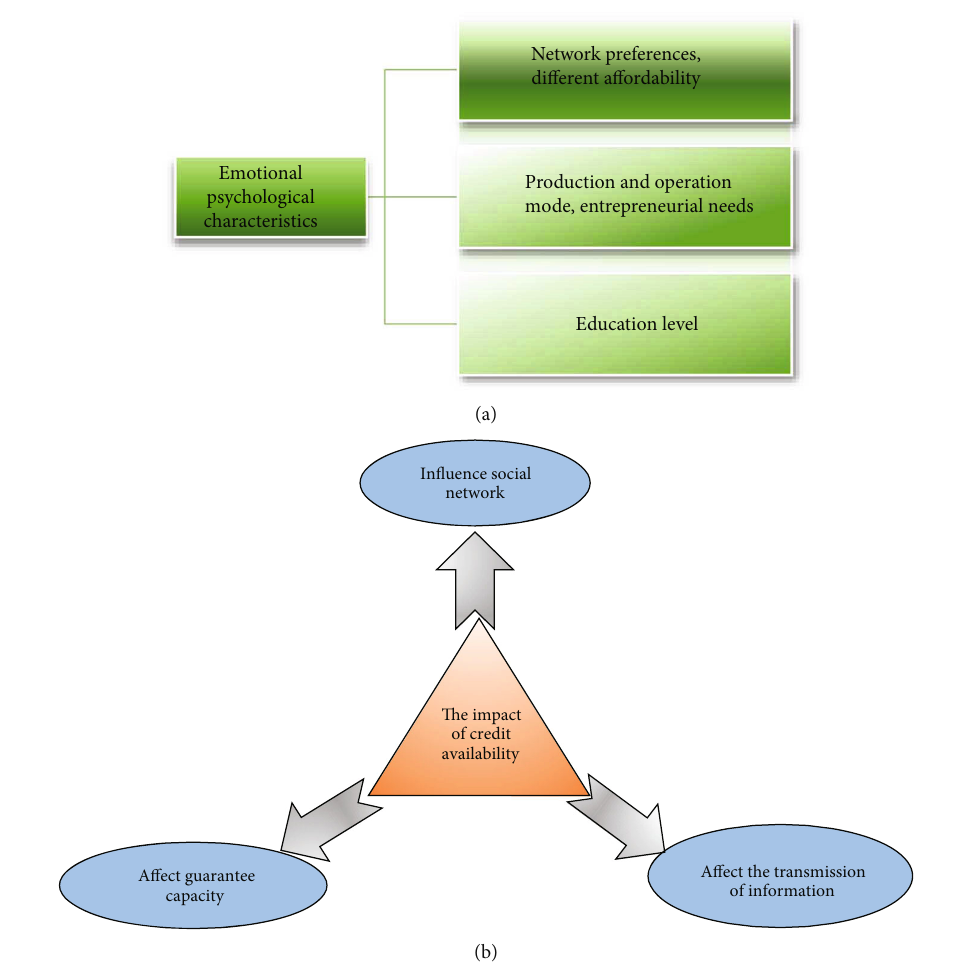
Figure 4: The in fl uence of emotional and psychological characteristics on herdsmen ’ s credit behavior (a) direct in fl uence; (b) indirect in fl